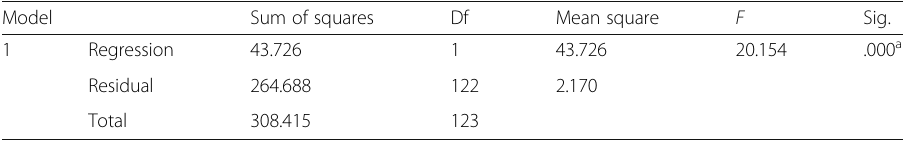
Table 11 ANOVA — marketing strategy Model Sum of squares